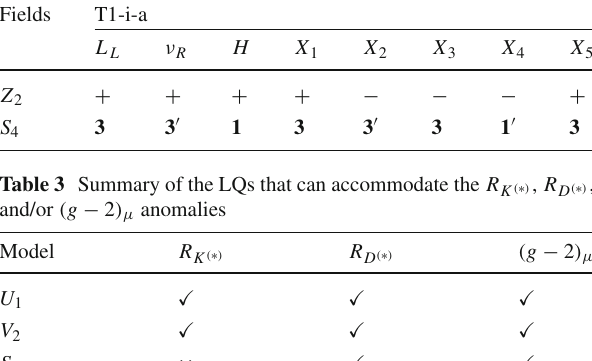
Table 2 Forbidding the lower-order contributions in the UV models of the diagram T1-i-a under the S 4 symmetry. We list also the transforma- tion properties of the relevant fields under the Z 2 symmetry Fields